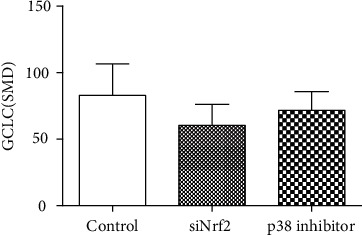
Meta-analysis of the effects of siNrf2 and p38 inhibitor on GCLC in vitro. SMD: standardized mean difference. Compared with control, the P value of the siNrf2 group's overall effect test is 0.02, and the P value of the p38 inhibitor group's overall effect test is 0.00001. When P < 0.05, the difference was considered statistically significant.